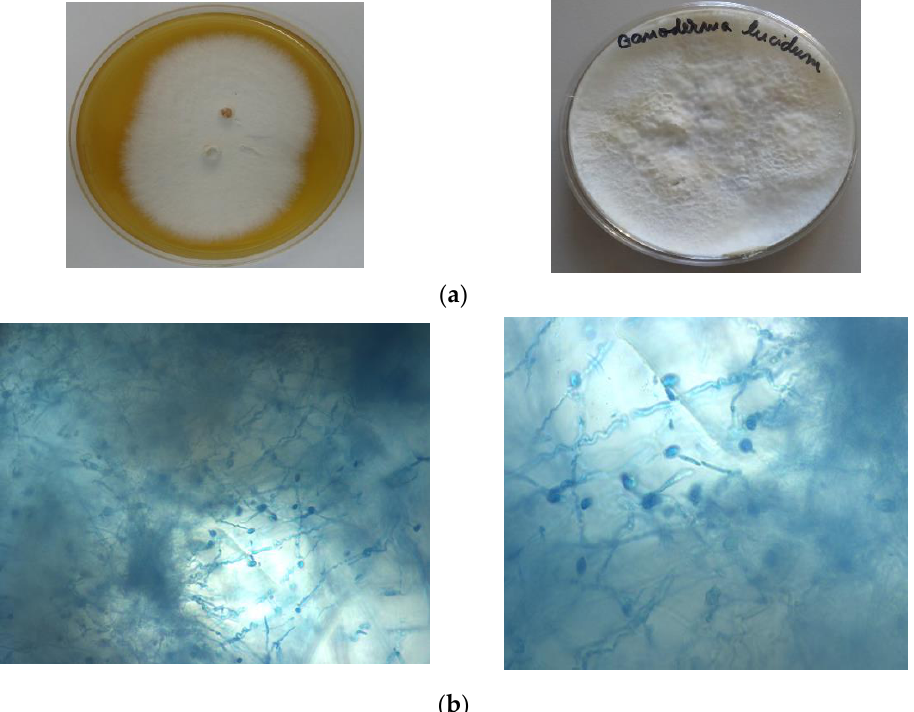
Figure 1. Macro- and microscopic observations of Ganoderma lucidum culture. ( a ) Macroscopic observations of Ganoderma cultures on malt-peptone agar medium. Mycelium fungus grown in the laboratory; ( b ) Microscopic observations (Olympus BX 51); spores and fungal filaments, lactophenol staining ( × 20 left, × 40 right).